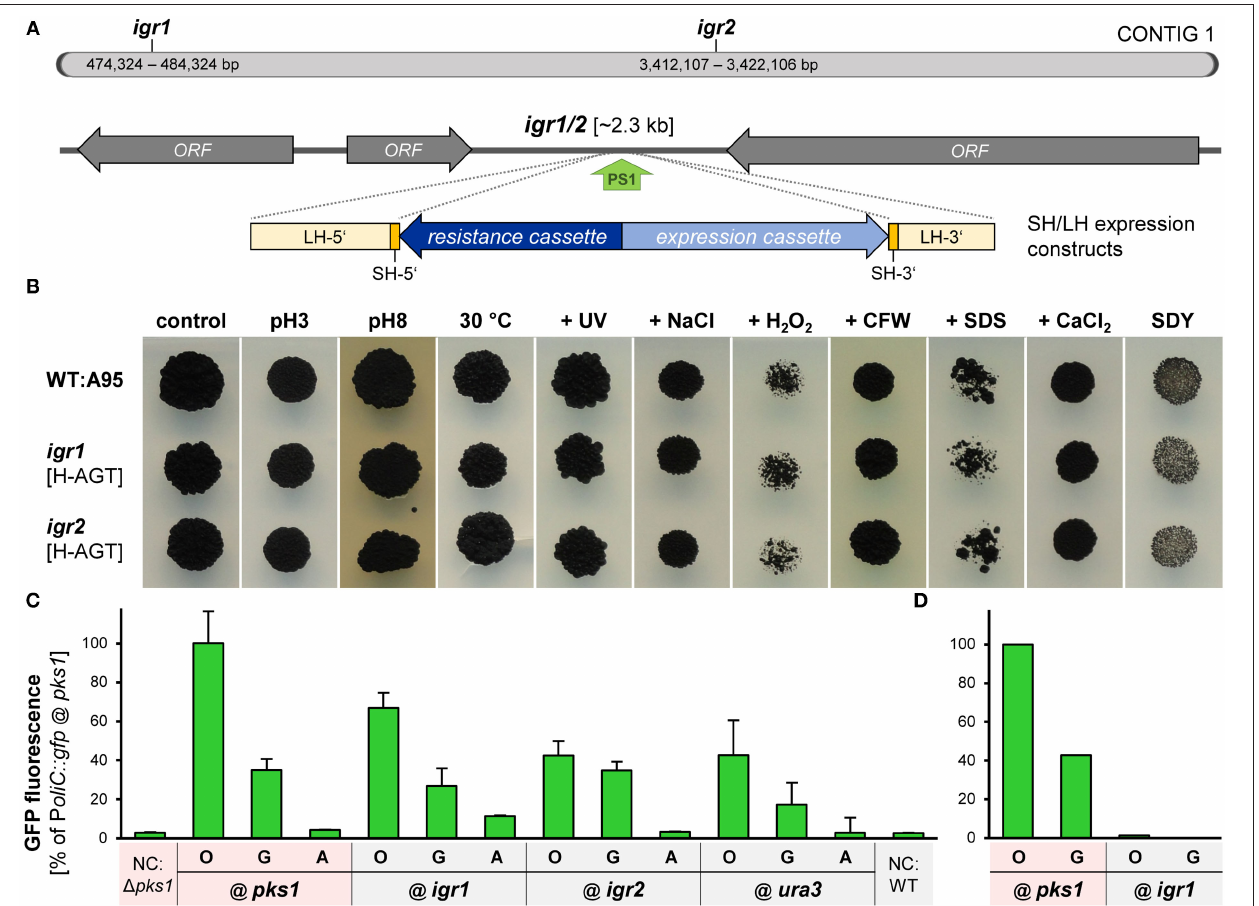
FIGURE 6 | Igr1 and igr2 are neutral genomic regions for targeted integration of expression constructs into the genome of K. petricola . (A) Scheme of contig 1 with the studied intergenic regions 1 and 2 ( igr1/2 ) of K. petricola A95. Two regions between converging ORFs with sizes of ∼ 2.3kb and moderate GC contents were chosen as candidates for neutral genomic regions. The green arrow (PS1) indicates the Cas9 cutting site. For insertion via HR (dashed lines), the expression constructs (blue arrows) were amplified by PCR using primers with SH sequences as 5 ′ overhangs (yellow boxes) or isolated by digestion from cloned plasmids (LH sequences; light yellow bars). (B) Insertions of different expression constructs at igr1 and igr2 do not result in growth phenotypes. Insertional strains were generated by co-transformation of WT:A95 protoplasts with pAMA/ribo- igr1 PS1 or pAMA/ribo- igr2 PS1 and different expression constructs flanked by appropriate homologous sequences to igr1 or igr2 as listed in Supplementary Table 4 . The growth phenotypes under different stress conditions were evaluated for two insertional strains with different expression constructs (H-AGT, N-OCT) per genomic locus. Cell suspensions of the gfp - or mch -expressing strains were dropped onto solid SDYG pH 5 (control) and modified media. Results for WT, one strain per igr and dropping of 10 4 cells are exemplarily shown. The entire dataset including details on the applied stresses is shown in Supplementary Figure 14 . Pictures were taken after 9 days of incubation. (C) Gfp controlled by P oliC and P gpdA is considerably expressed when inserted in igr1 or igr2 . Strains comprising identical P oliC :: gfp (O), P gpdA::gfp (G) and P act1::gfp (A) cassettes in different genomic regions i.e. igr1 , igr2 (B), 1 pks1 ( Figure 4A ), and 1 ura3 ( Supplementary Figure 15 ) were cultivated for 4 days in liquid SDNG. Cell suspensions were dropped onto objective slides